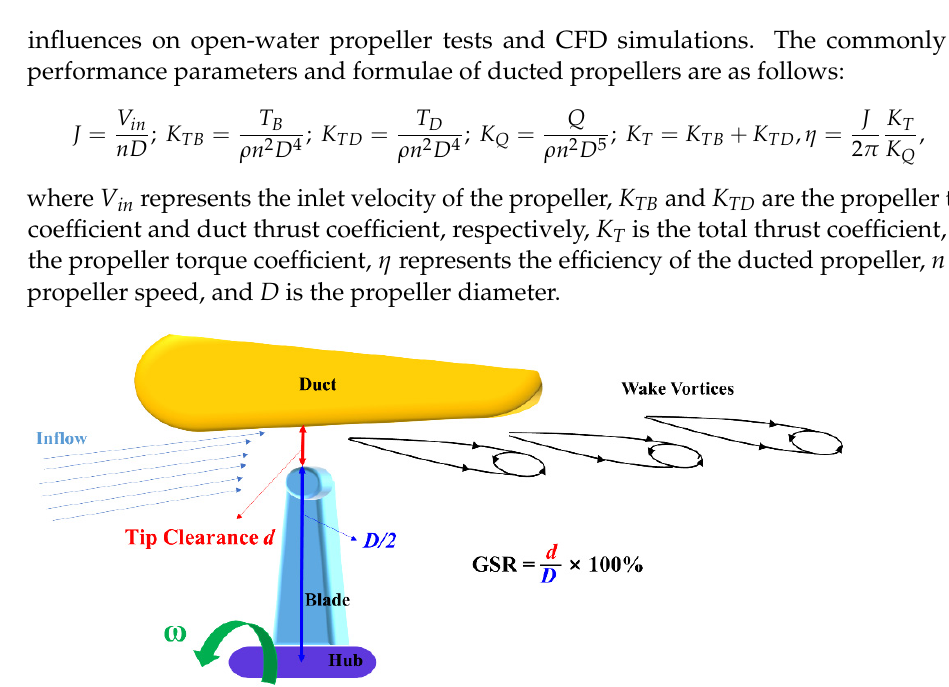
Figure 2. Schematic diagram of the ducted propeller’s flow field.